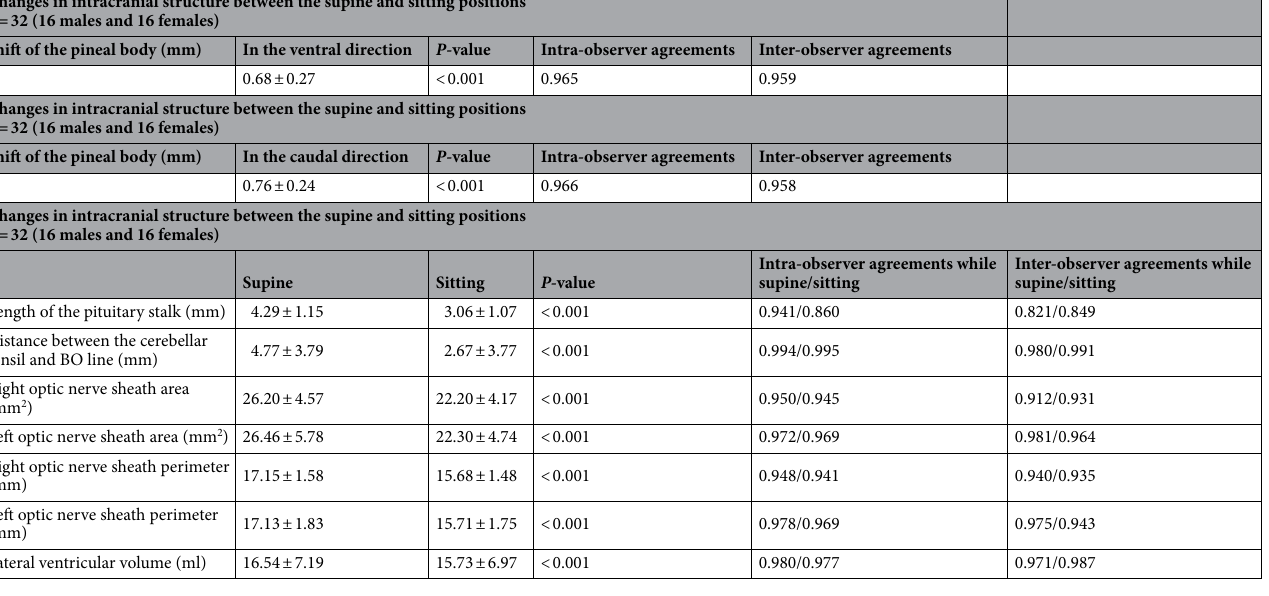
Table 2. All parameters are described in the supine and sitting positions. In the sitting position, the pineal body shifted ventrally and caudally, cerebellar tonsil descended, and the optic nerve sheath area, perimeter, and lateral ventricular volume decreased significantly. BO line : basion-to-opthision